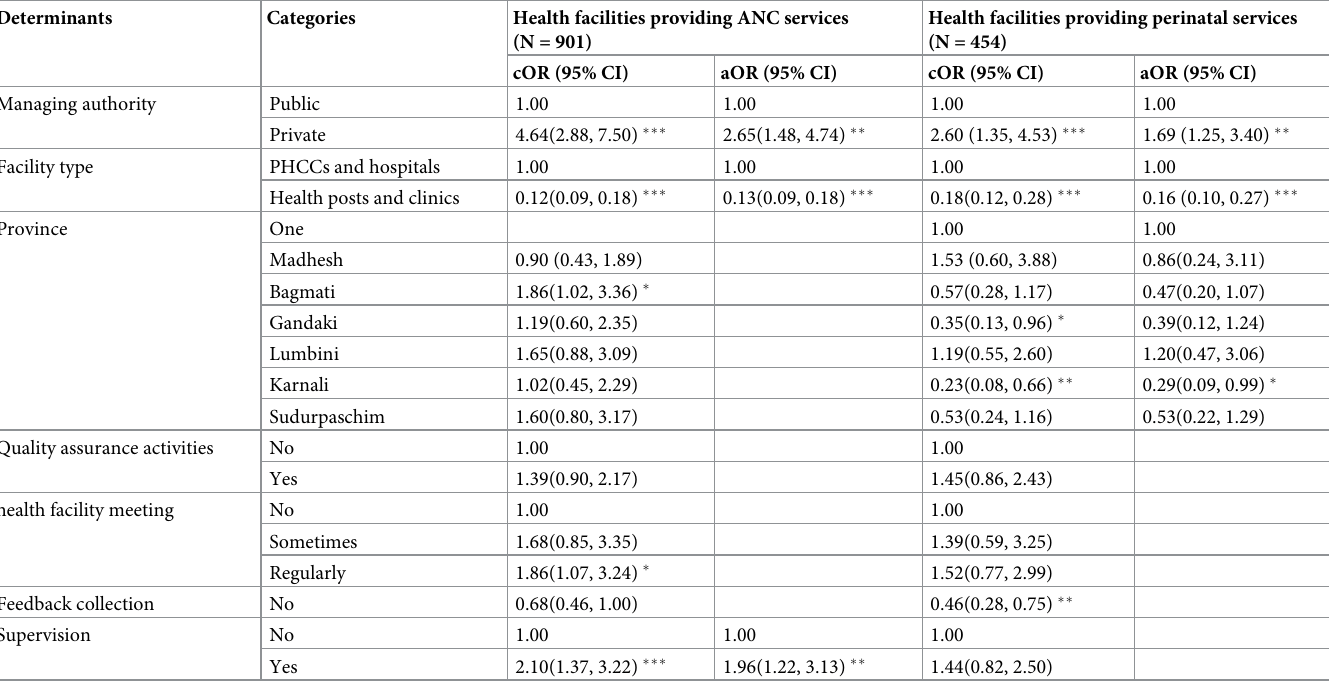
Table 5. Determinants associated with optimal structural quality of health facilities for routine MNH services in Nepal, 2015.